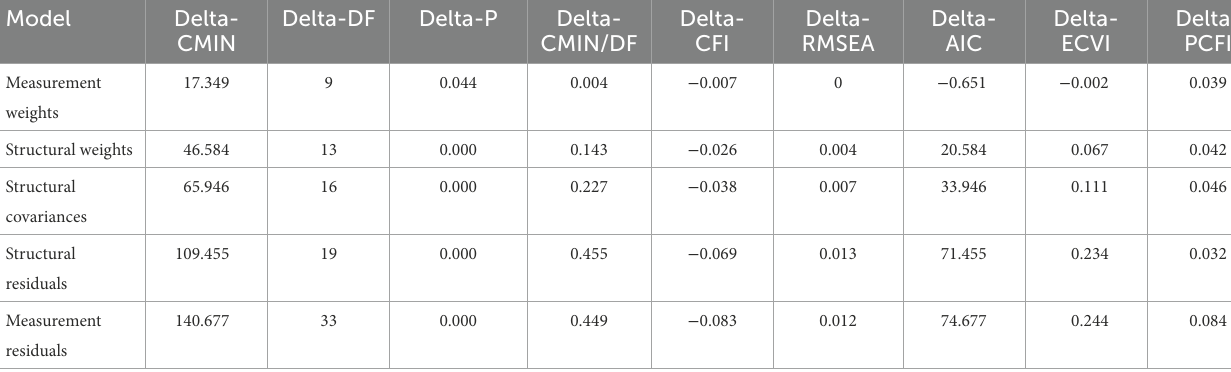
TABLE 6 Results of the invariance test.